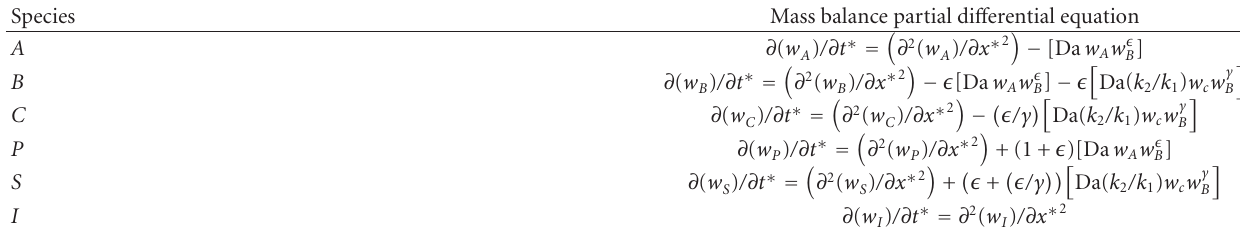
Table 5: System of equations for competitive-parallel reaction scheme, to be used with (1) and (3).